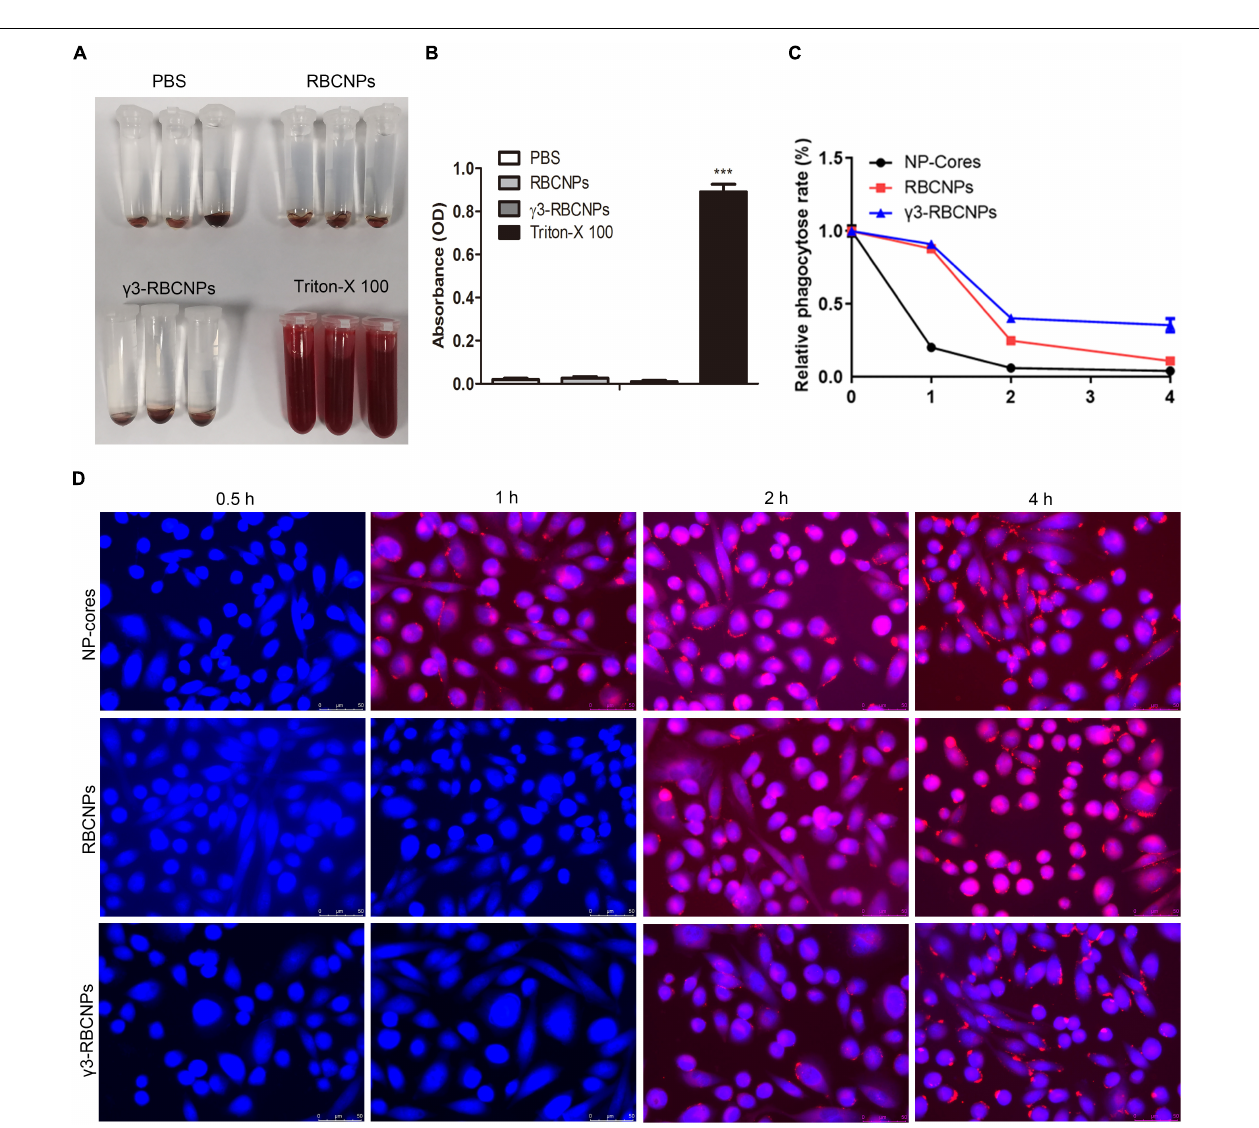
FIGURE 5 | In vitro evaluation of γ 3-RBCNPs. (A,B) Assessment of the hemolytic activity of NP-cores, RBCNPs, and γ 3-RBCNPs, PBS was used as the negative control, and Triton-X100 was used as a positive control. (C,D) The phagocytosis of RBCNPs and γ 3-RBCNPs by macrophages in vitro was observed by LSCM. Scale bar = 50 µ m. *** P < 0.001 vs. PBS